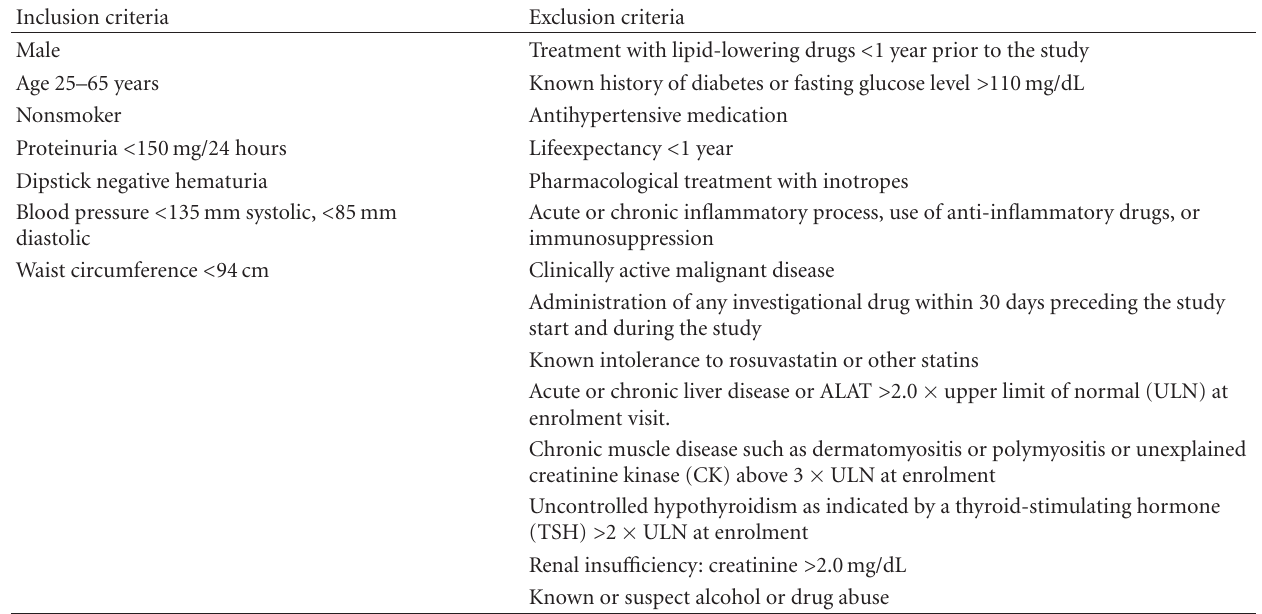
Table 1: Inclusion and exclusion criteria of the